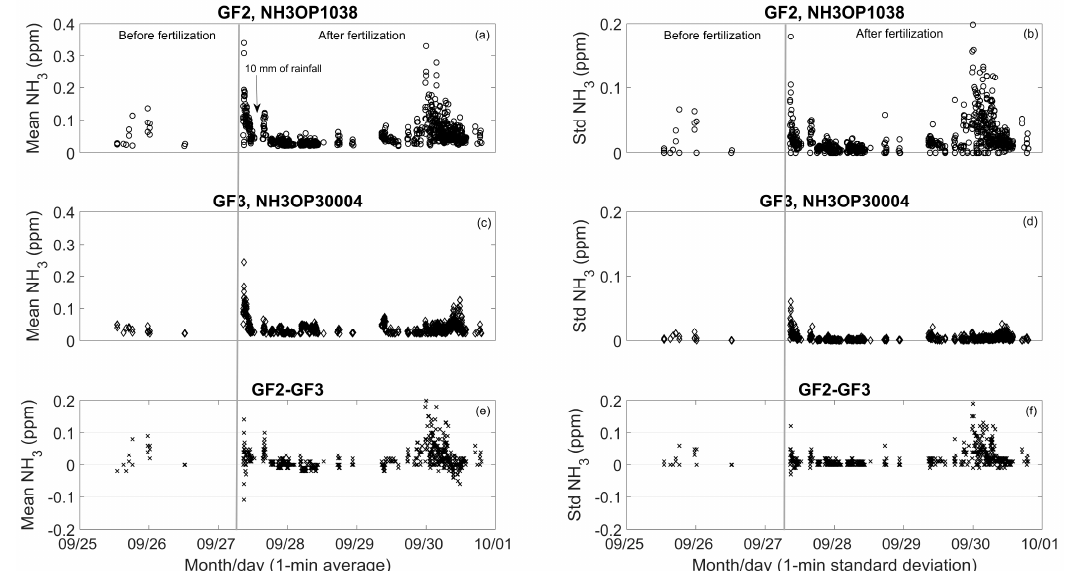
Figure 5. Means ( a, c, e ) and standard deviations ( b, d, f ) on a 1 min period basis of NH 3 concentrations measured by the GF2 (NH3-OP1038) and GF3 (NH3-OP30004) at the field trial two days before fertilization and four days during and after fertilizer application. The data shown have not been filtered based on atmospheric turbulence conditions. Atmosphere 2019 , 10 , x FOR PEER REVIEW 11 of 14